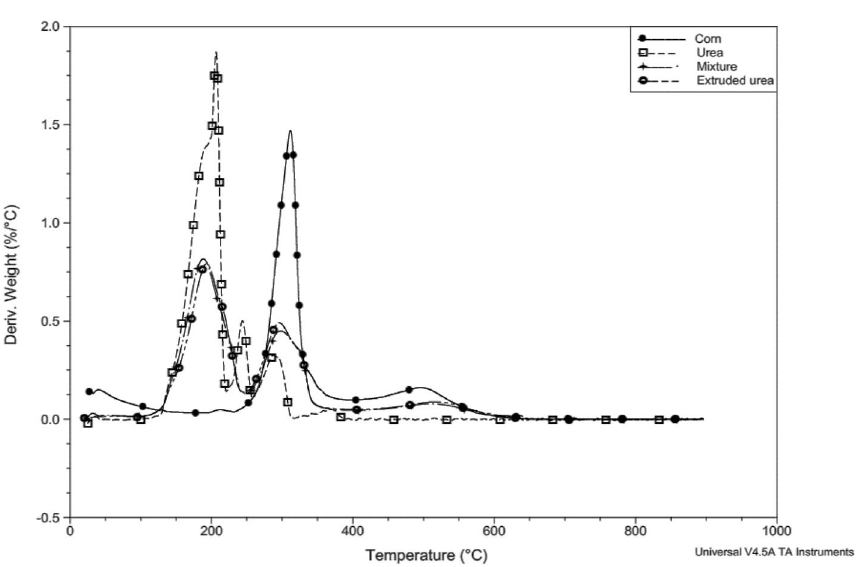
Figure 4. Overlapping DTG curves of urea, ground corn, mix corn and urea, and extruded